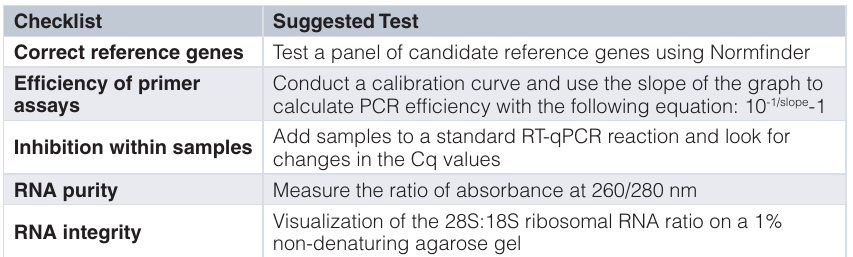
Table 3. Checklist of tests to conduct when designing RT-qPCR studies.